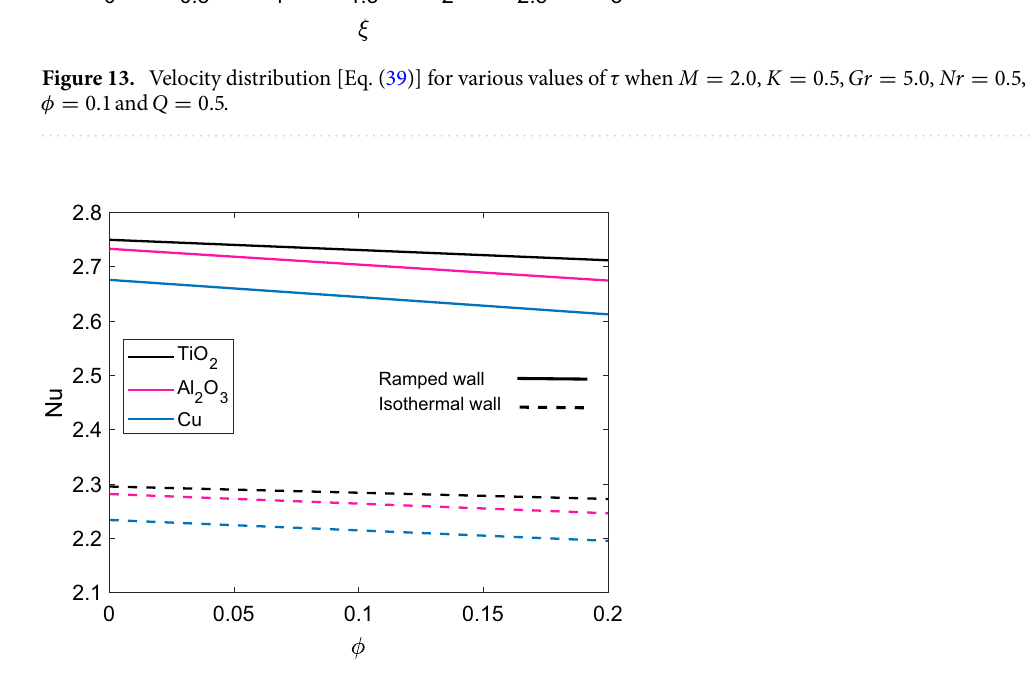
Figure 14. Comparison of heat transfer rate [Eq. (41)] for different nanofluids when Nr = 0.5 and Q = 0.5 .